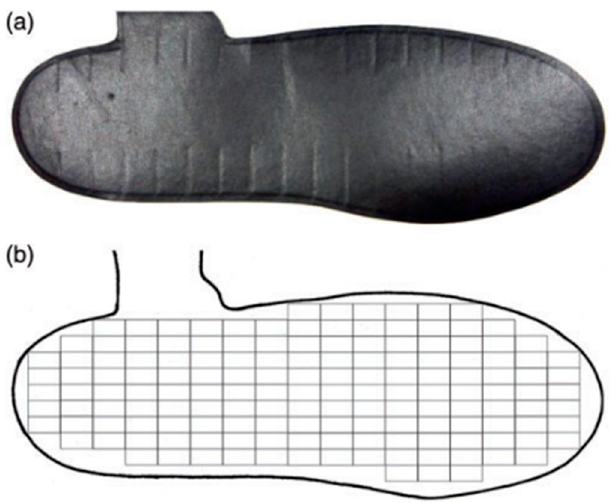
Figure 1. Subject using AlterG ® Treadmill with Medilogic ® Pressure-Measuring Insoles.